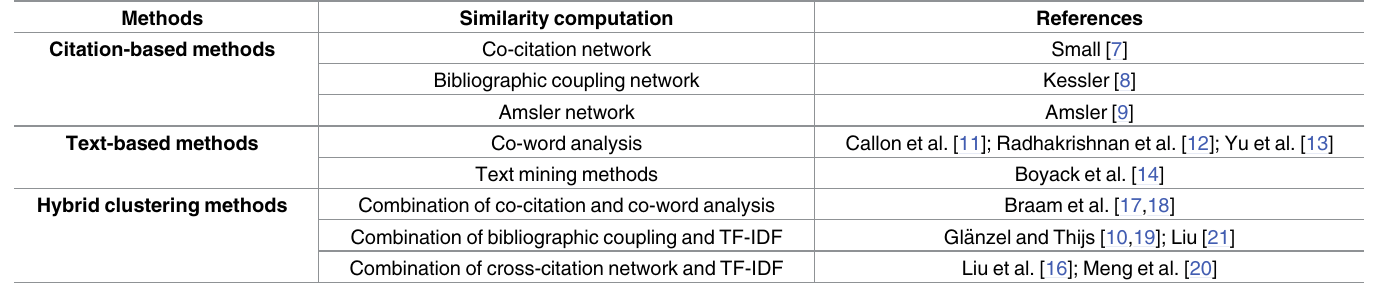
Table 1. Related work of clustering methods based on citation links and textual